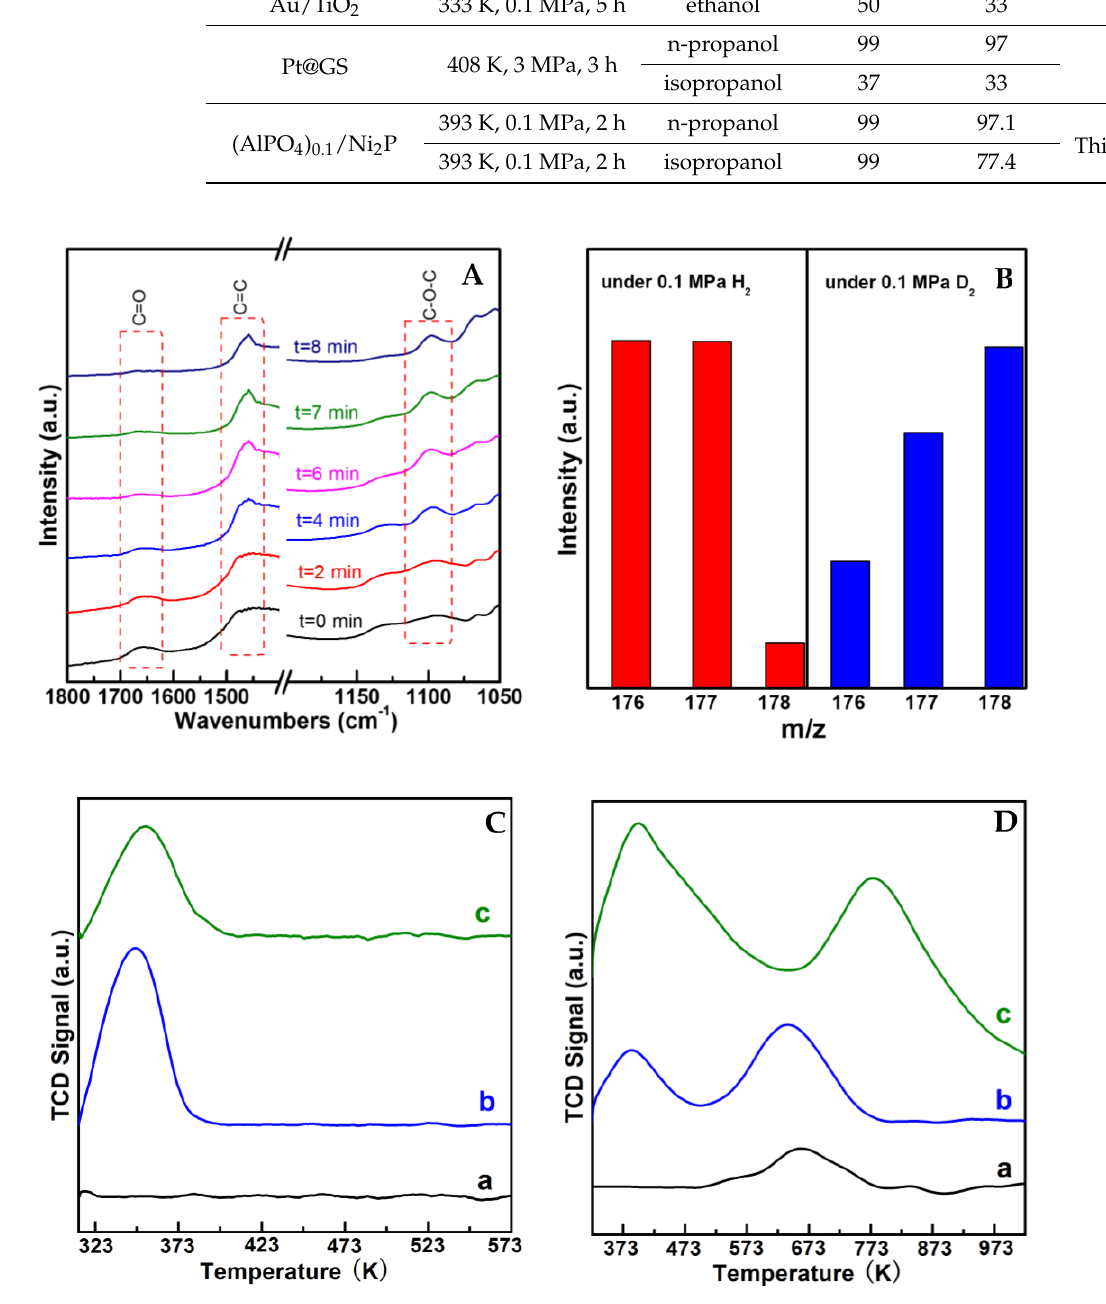
Figure 5. Mechanism investigation results over typical catalysts. ( A ) In situ FT-IR spectra by intro- ducing H 2 on (AlPO 4 ) 0.2 /Ni 2 P with cinnamaldehyde(CA) and propanol chemisorbed